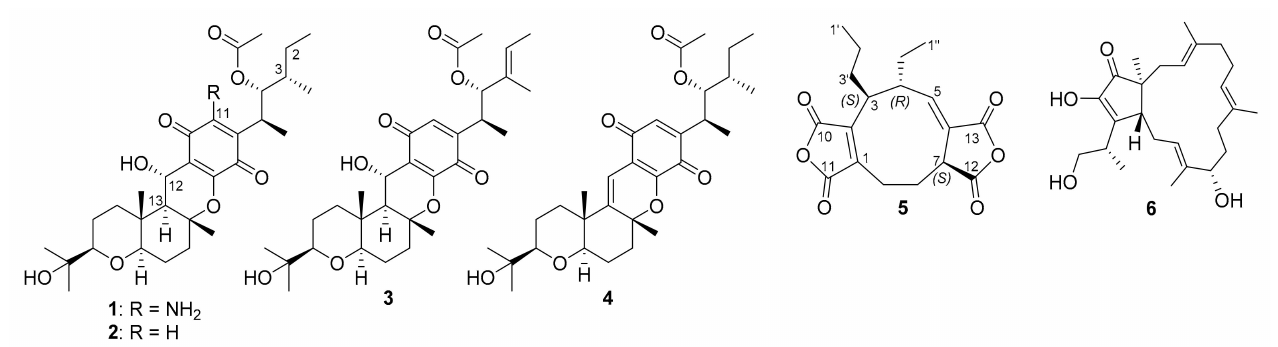
Figure 1. Compounds isolated from Curvularia